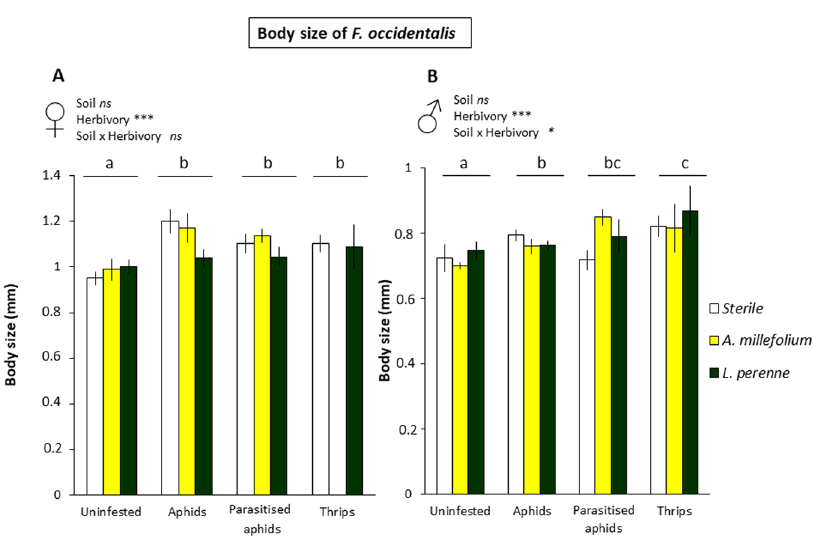
Figure 4. Performance of F. occidentalis , length of body size in adult stage for female ( A ) and male ( B ) thrips on C. annuum for four different treatments: (a) uninfested plants, (b) aphid infested plants, (c) parasitised aphid infested plants, (d) thrips infested plants, on three different soil types: (a) sterile soil, (b) A. millefolium , (c) L. perenne . Bars represent means ± SE (n = 12). No surviving females were found in thrips infested plants grown on A. millefolium soil. Different letters indicate significant pairwise differences between infestation treatments (P <